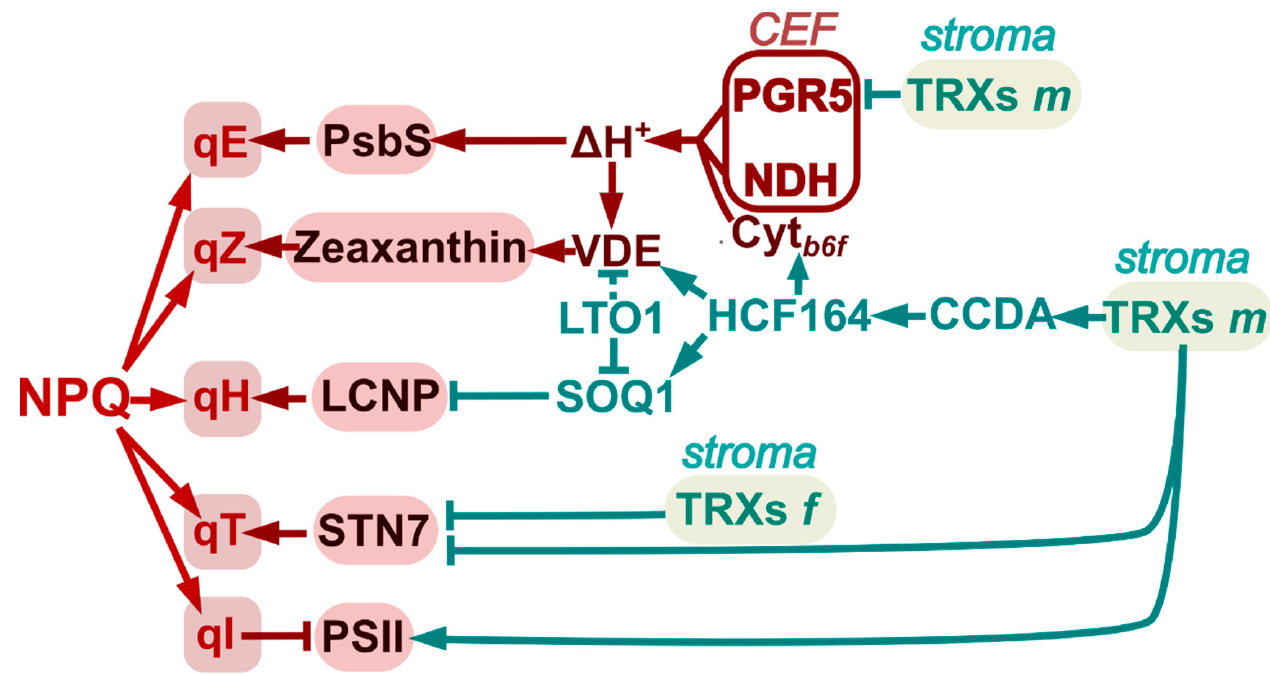
Figure 2. Schematic representation of the redox regulation mediated by TRXs f and m of the NPQ components in Arabidopsis . The type of interaction is either represented in green (redox type) or in red (non-redox type). Arrows represent activation; truncated lines, inhibition. A dashed line indicates a hypothetical interaction.